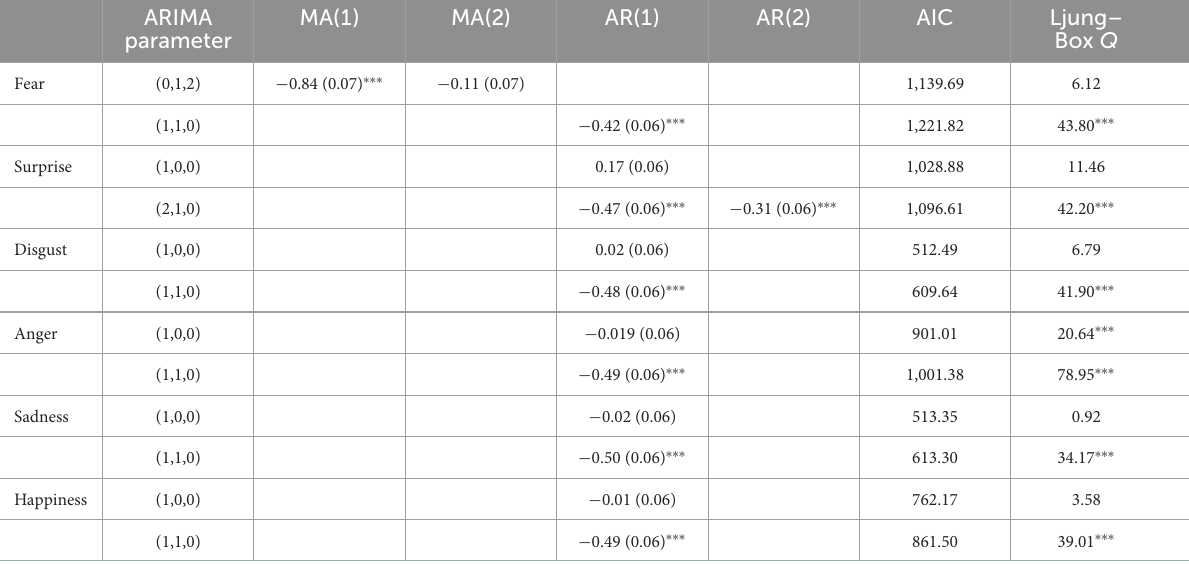
TABLE 3 ARIMA modeling results of the E Fund Blue Chip Select Mix Fund. ARIMA